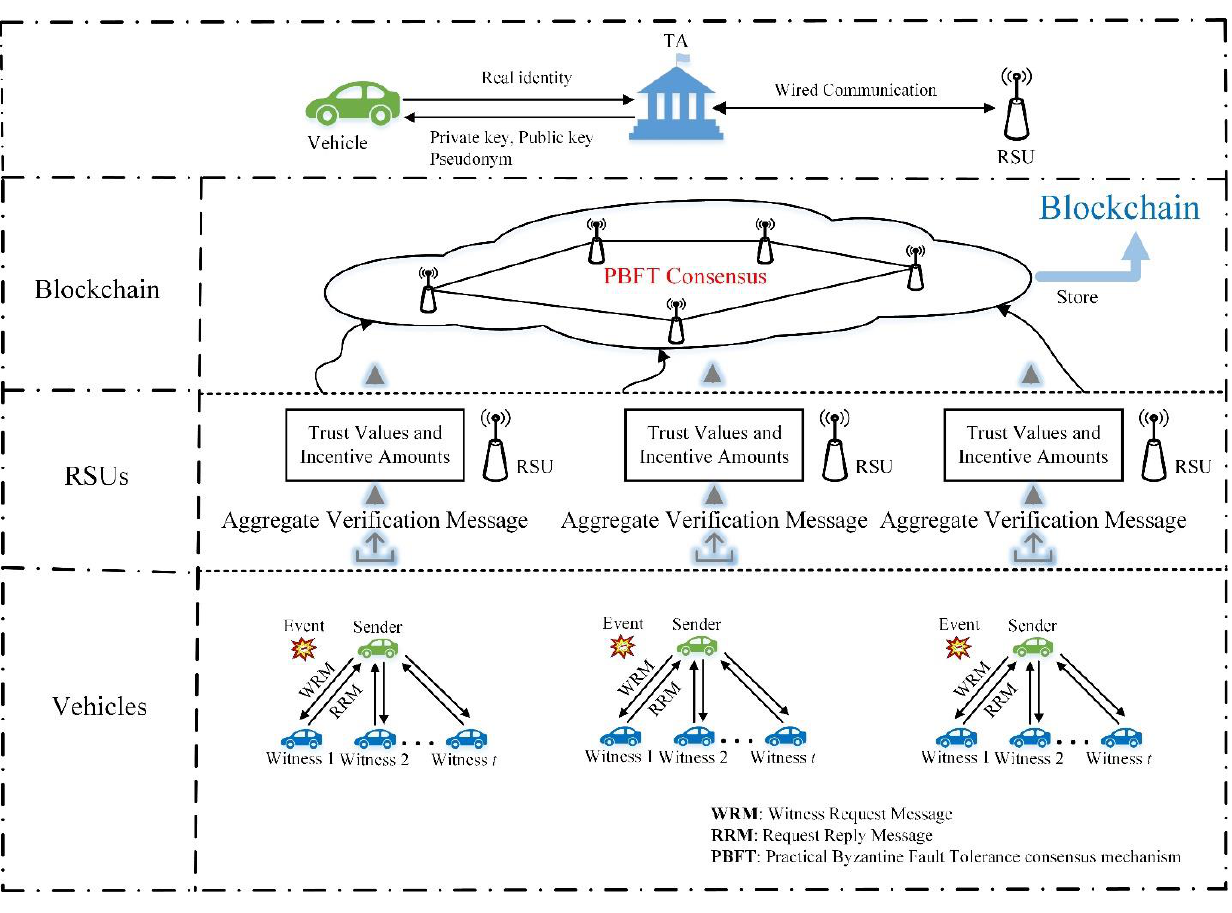
Figure 1. System